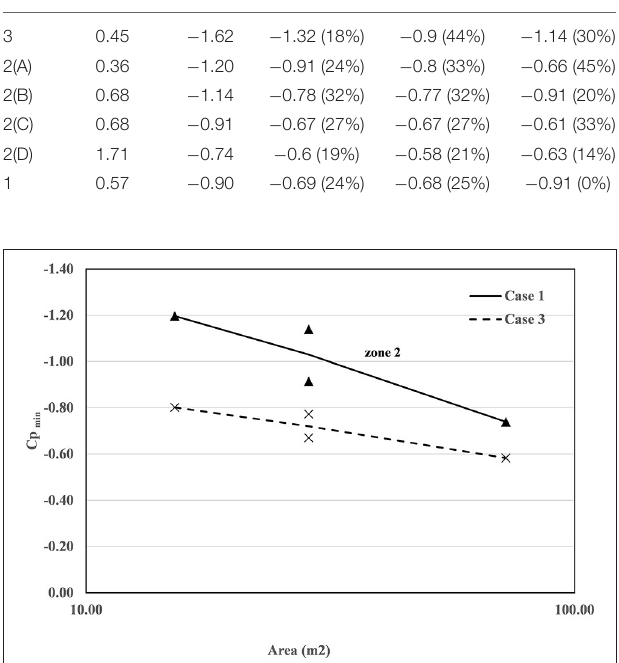
FIGURE 9 | Variation of C p min , 3s vs. effective area in zone